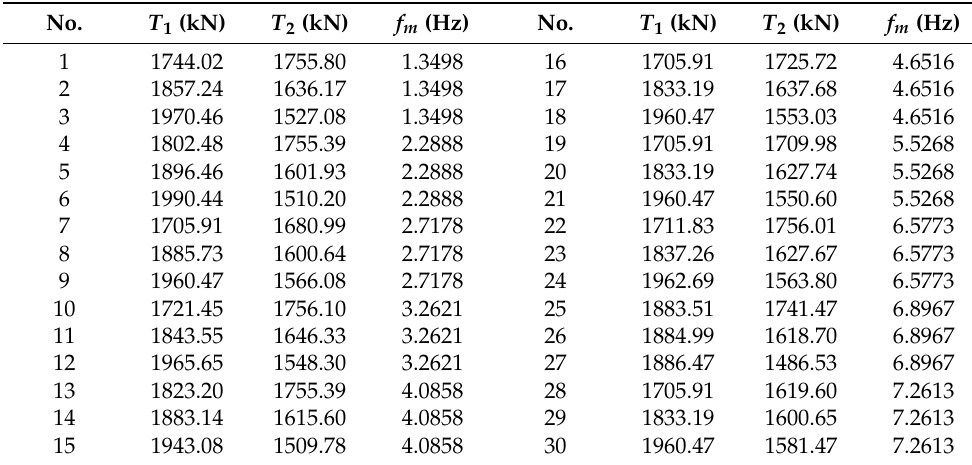
Table 9. Thirty combinations in numerous satisfied